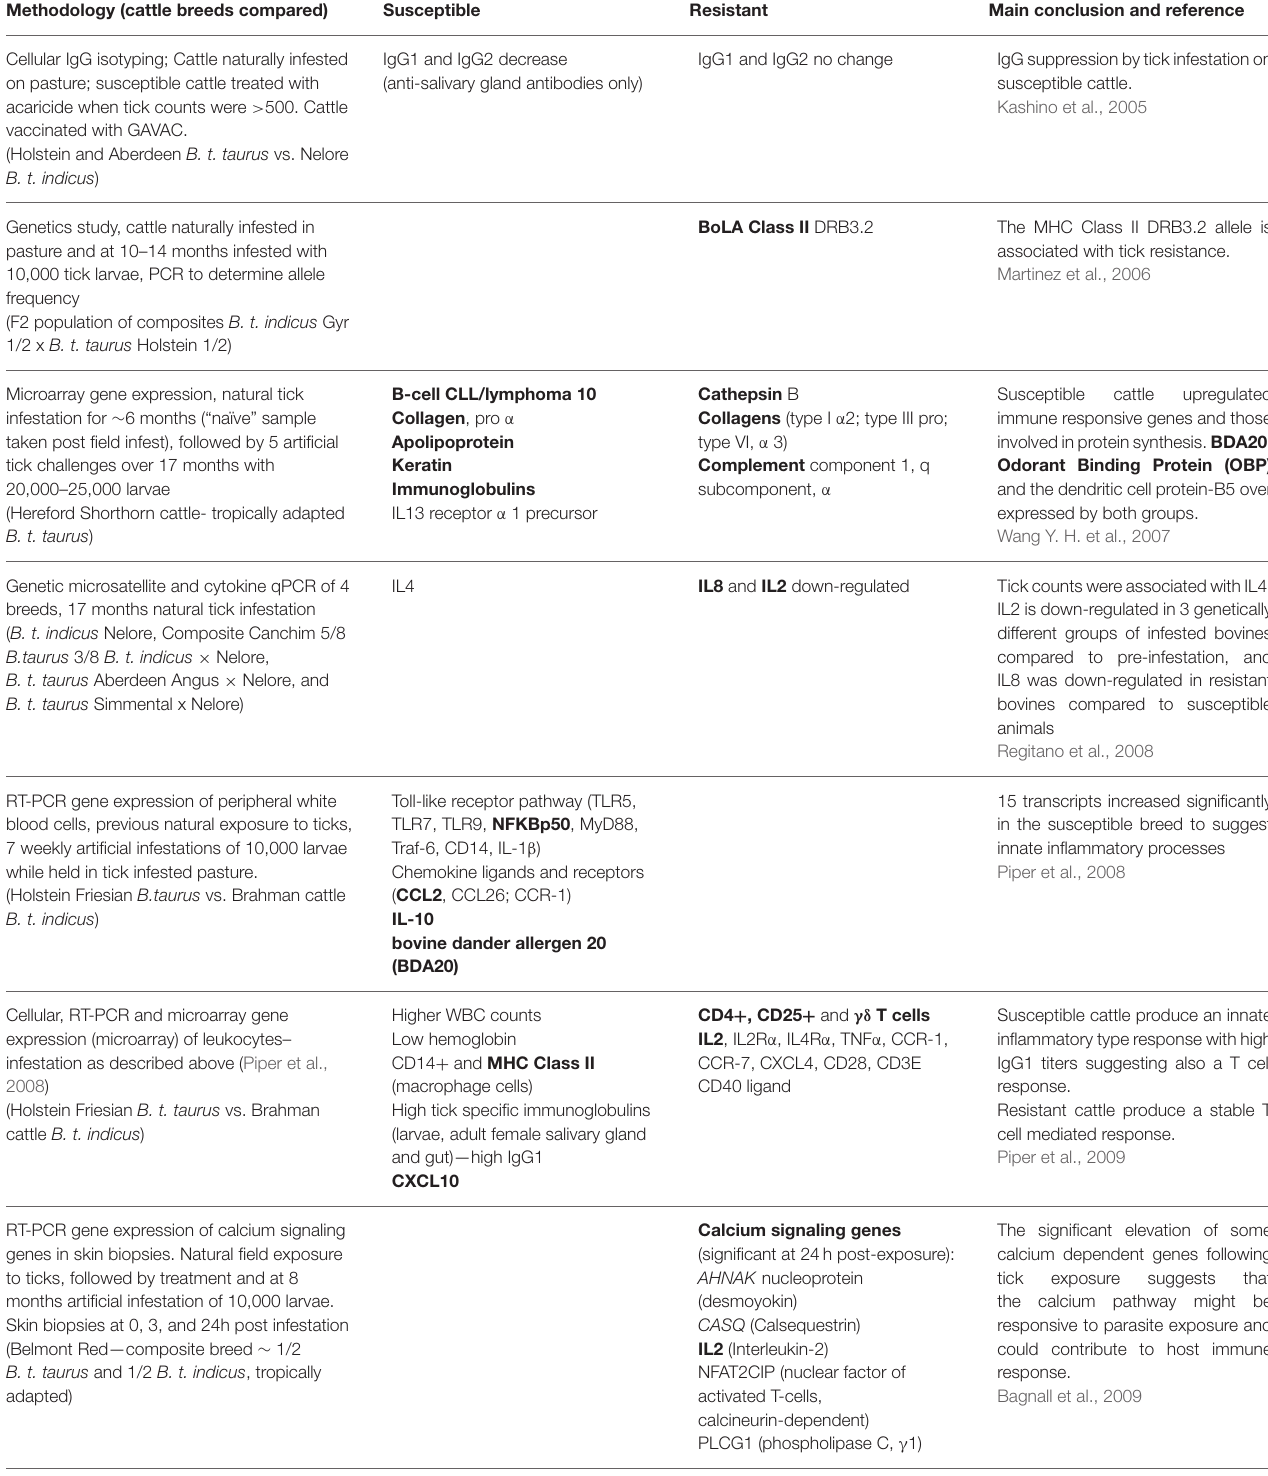
TABLE 1 | Summary of differentiating characteristics of tick susceptible vs. tick resistant cattle (bold font indicates correlation between studies of certain transcripts and or other markers—genetic, cellular, immunohistochemistry) in response to Rhipicephalus microplus ticks. Methodology (cattle breeds